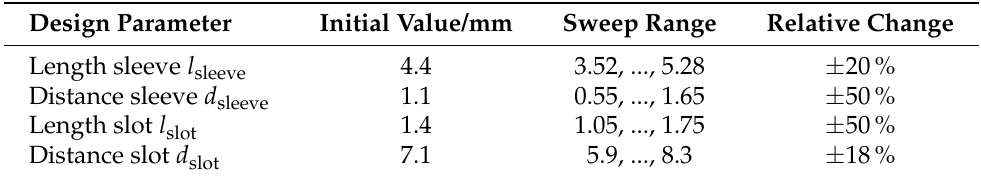
Table 1. Initial value and sweep range of design parameters for optimization of the dual-mode